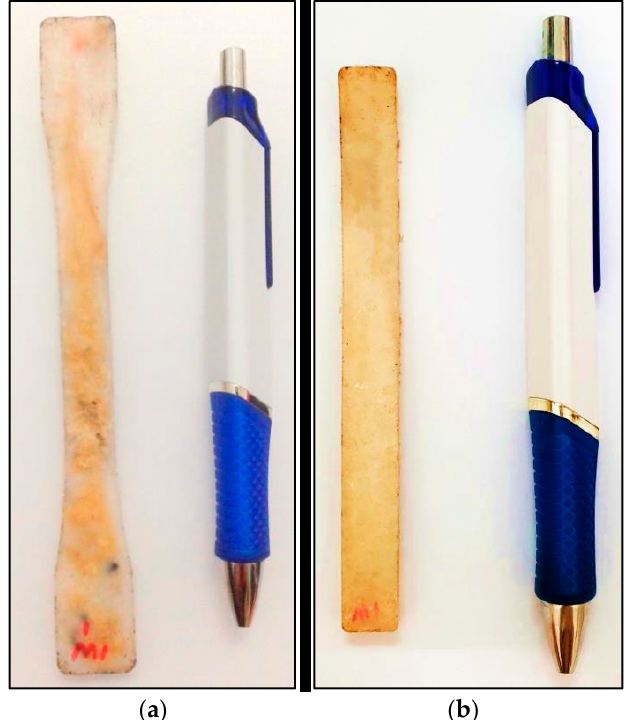
Figure 2. Composite insulation samples for the ( a ) tensile tests (dog-bone) and ( b ) flexural tests